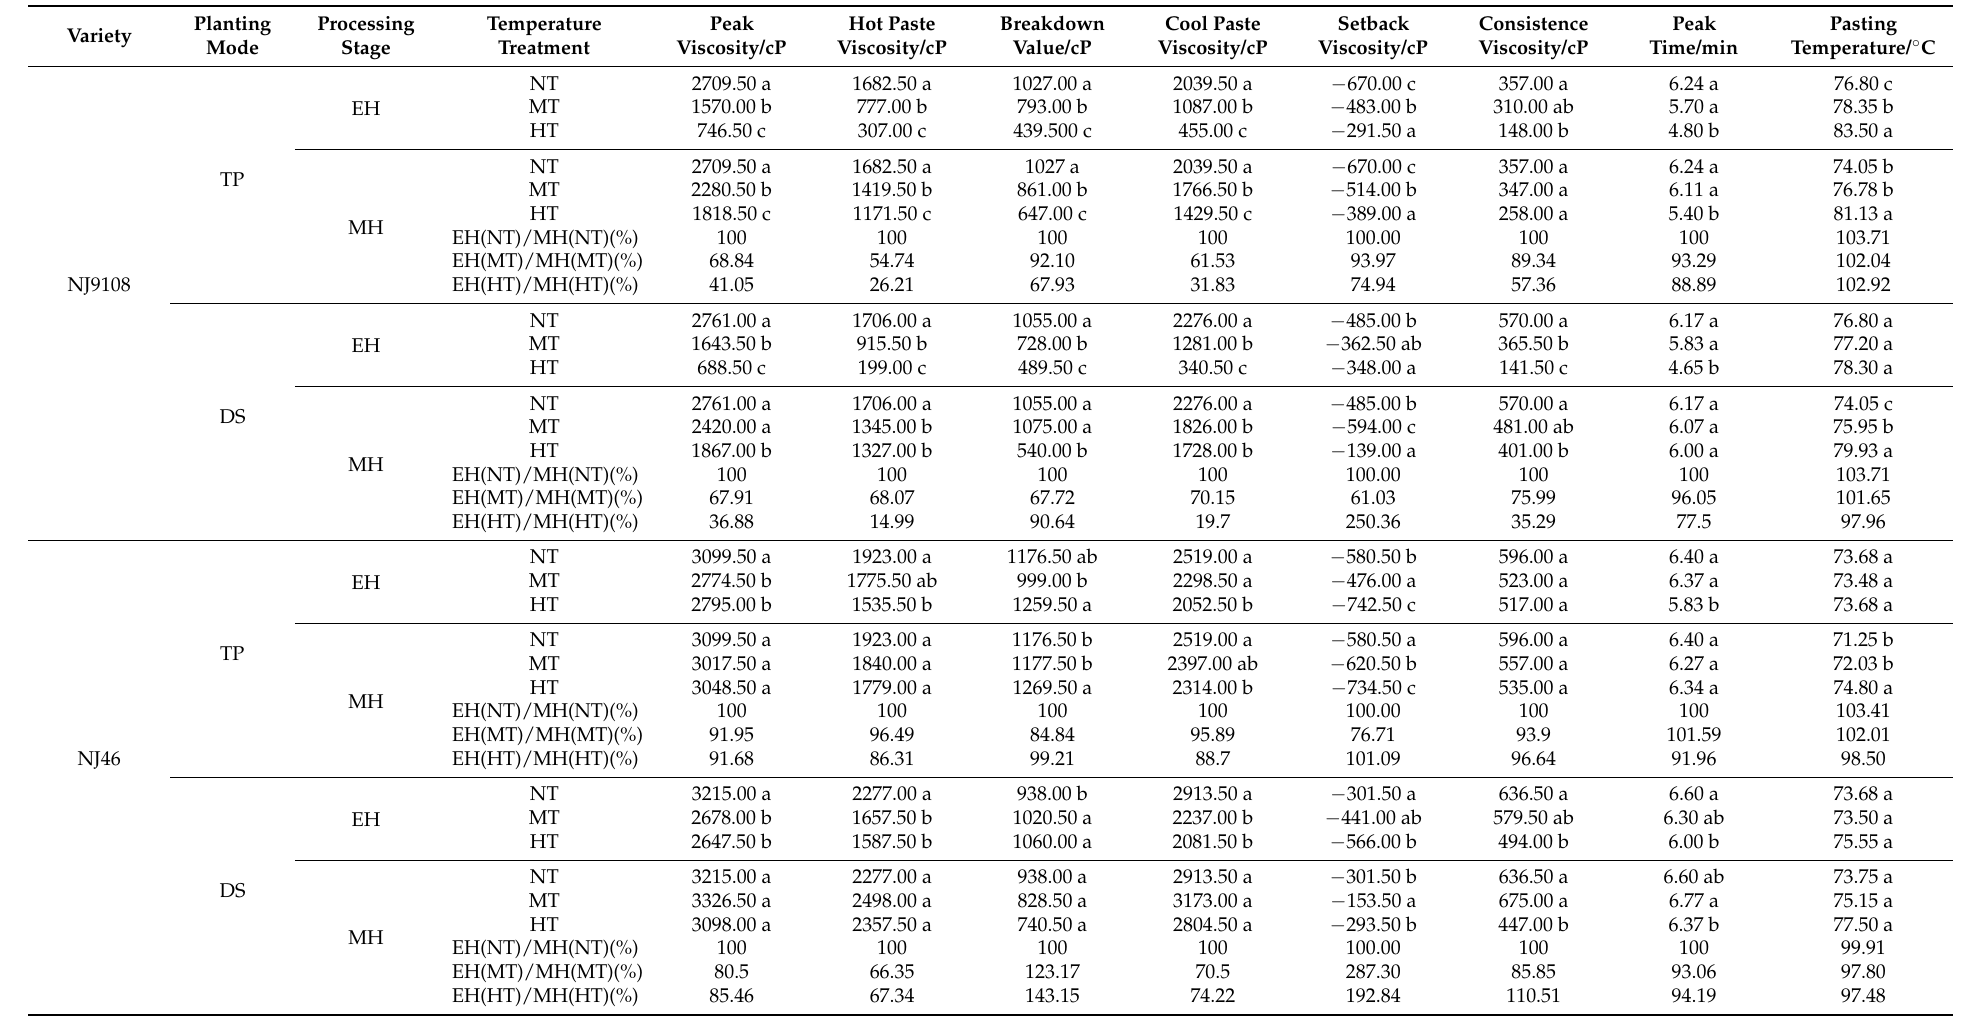
Table 6. Effects of high temperature on RVA of japonica rice in early and middle heading stage under transplanting and direct seeding.